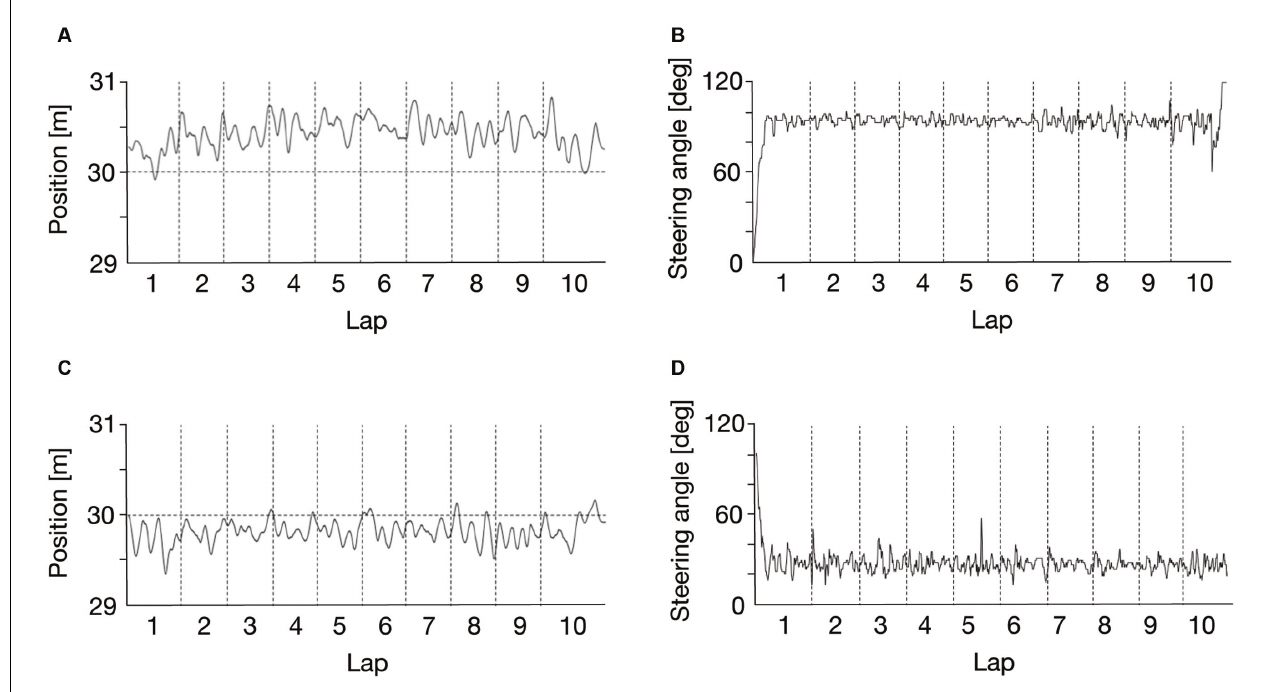
FIGURE 4 | Examples of vehicle position in the counter-clockwise circling condition (CC: A ) and the clockwise circling condition (CW: C ), and steering operation in the CC condition (B) and the CW condition (D) in the test session. Dotted horizontal black lines at 30 m in (A,C) indicate the center of the circular path, and black curved lines are the typical car movements (A,C) and steering operation (B,D) of one of the participants. The data of the first and last laps were excluded from data